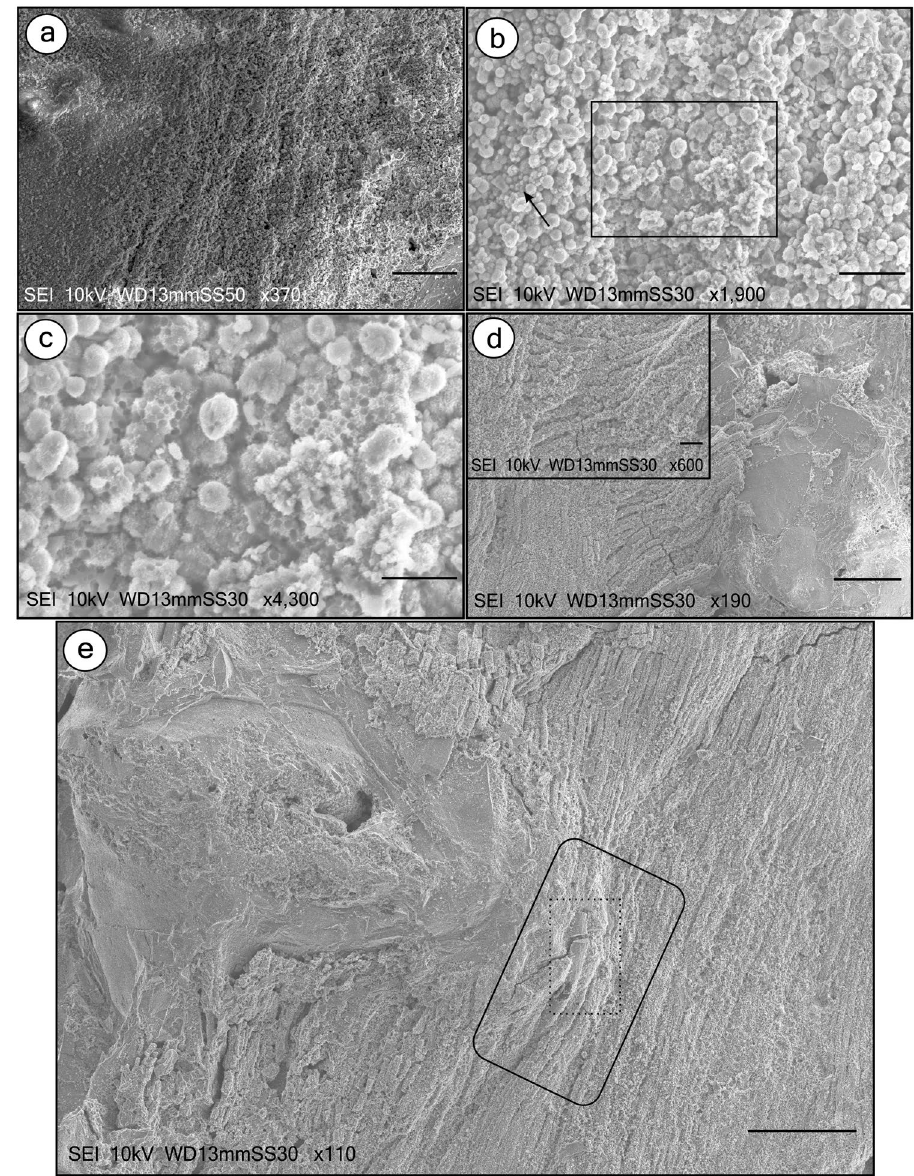
Figure 2. SEM of Crato Member BL fish soft-tissues and microfabrics. The images of the analyzed specimens and the localization of micrographs are depicted in Supplementary Figure 3. ( a ) depicts poorly-preserved muscle fibres, like diagonal ridges, at caudal fin base (Supplementary Figure 3). ( b ) shows that fibres are composed of Fe oxide/hydroxide (Supplementary Figure 5) sub-spherical to spherical grains with more than 1 µ m (and occasionally less than this size, indicated by arrow), locally merged and covered by a “fuzzy” coating. The area highlighted in ( b) , enlarged in ( c) , depicts Fe oxide/hydroxide honeycomb-like texture (Supplementary Figure 5). ( d ), Micrograph showing how muscles are attached to dorsal fin base via tendons and the way these muscles connect to those sub-parallel to column (Supplementary Figure 3). Inset details these observations. Microfabric composition is depicted in Supplementary Figure 5. ( e ) Micrograph of fish anteroposterior axis (below dorsal fin; Supplementary Figure 3). Images reveal how muscles attach to vertebra, revealing preserved tendons (dashed rectangle), and muscles connected to tendons (big rectangle). Scale bars: ( a) – 50 µ m; ( b )– 10 µ m; ( c) – 5 µ m; ( d) , ( e )– 100 µ